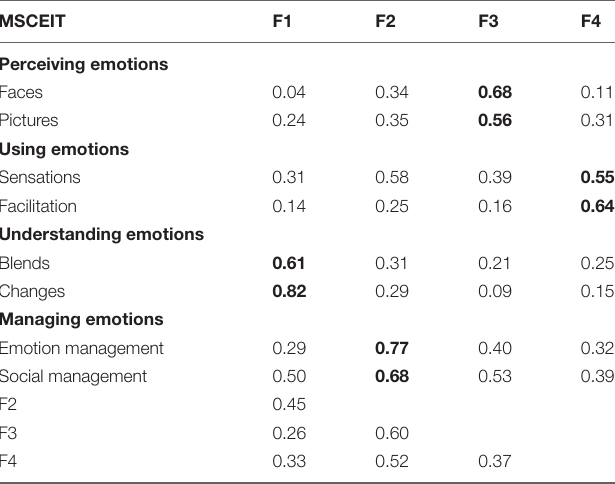
TABLE 2 | Factor matrix and correlations among the obtained